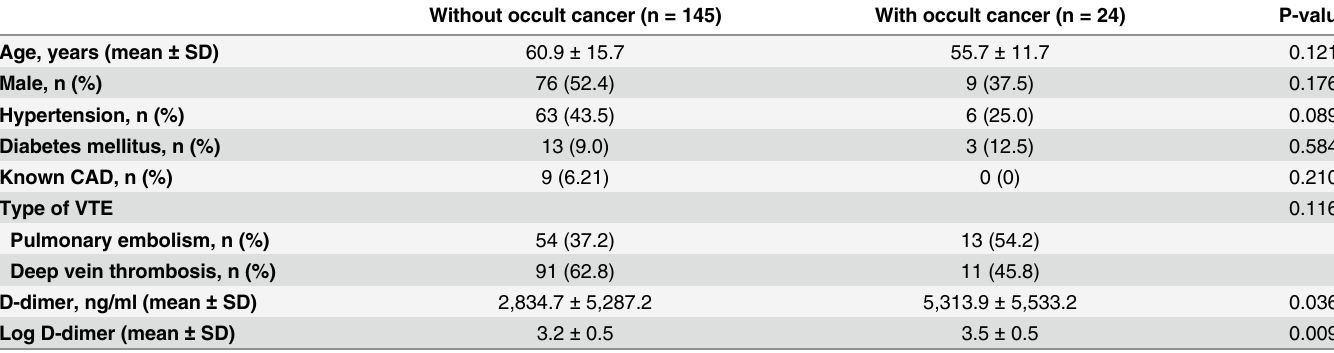
Table 2. Baseline characteristics between patients with and without occult cancer.